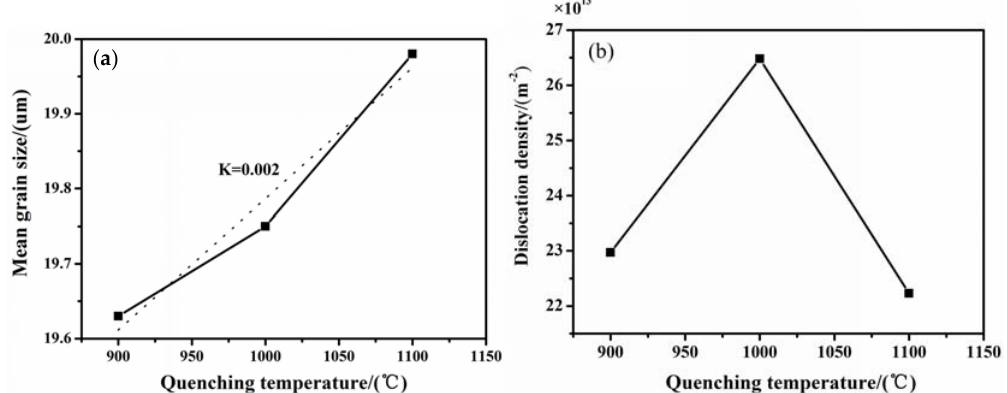
Figure 6. ( a ) the mean size of crystal and ( b ) dislocation density of samples at different quenching temperatures.